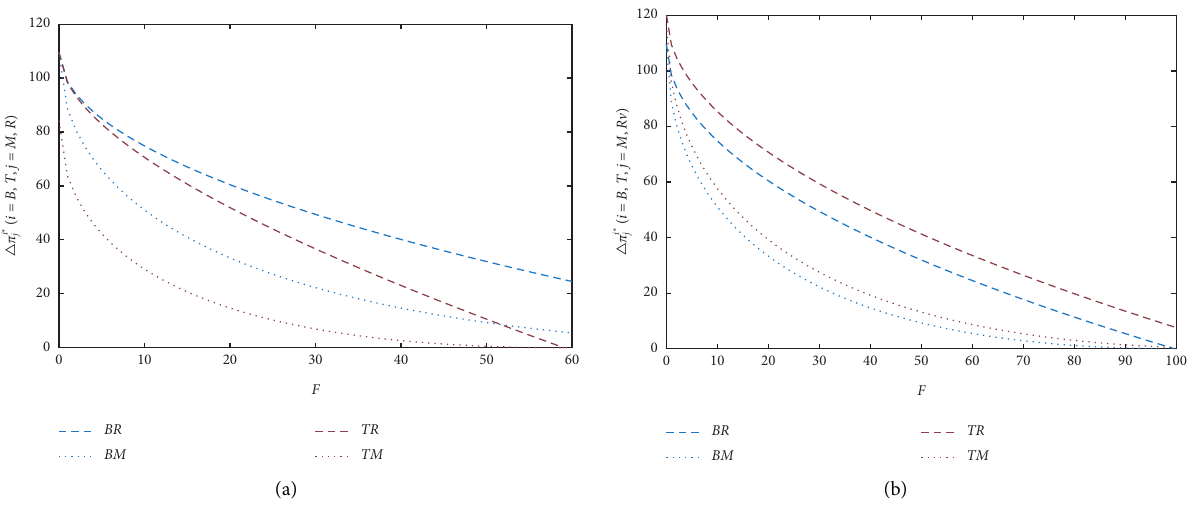
Figure 5: The influence of initial capital on the profit improvement of the manufacturer and retailer. (a) θ � 0 . 3. (b) θ � 0 .